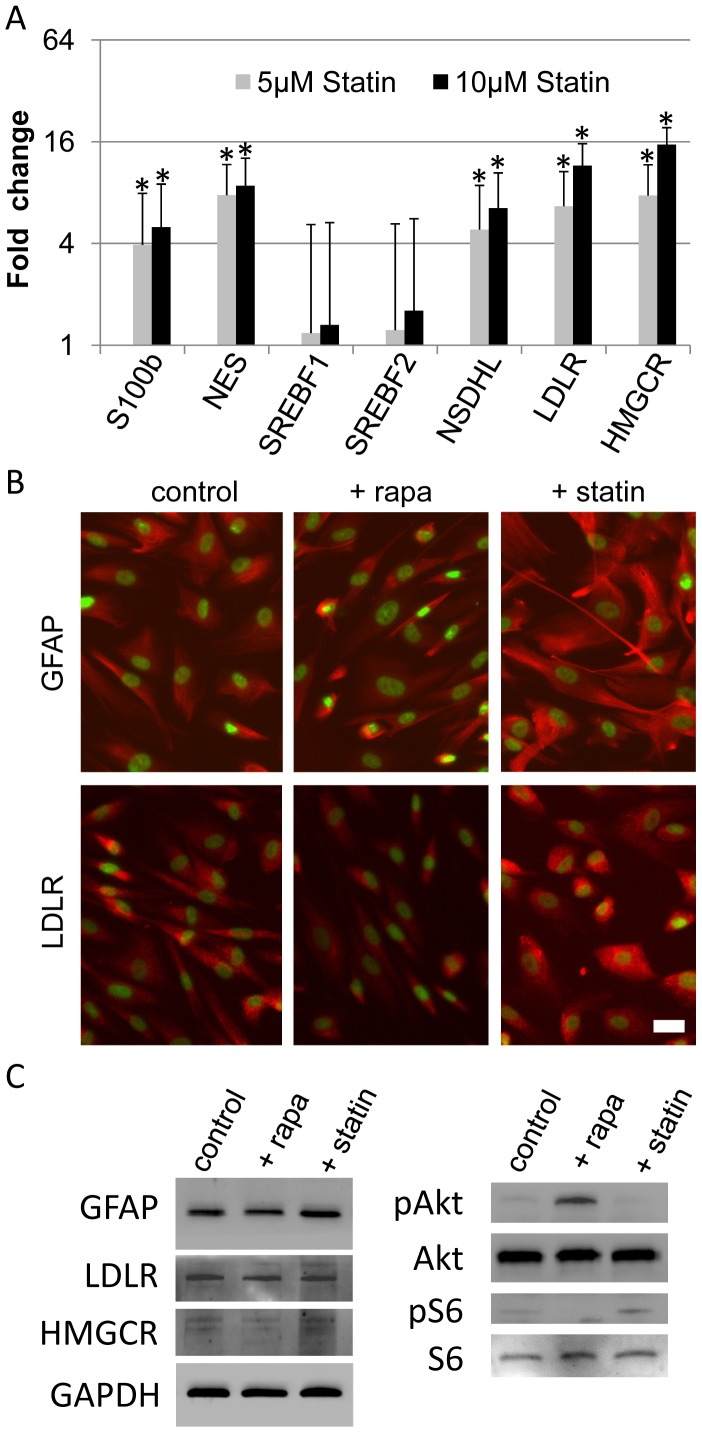
Rapamycin decreases Schwann cell markers, whereas statin induces Schwann cell markers.(A) During the last 72 hrs of differentiation, AFS cells were treated with 5 µM and 10 µM statin. After 15 days cDNA was generated and used for quantitative PCR of respective genes. The results are expressed as means ± SEM of three independent experiments. P<0,05 for * vs control treated cells. (B) AFS cells were differentiated for 15 days and since day 5 continuously treated either with 25 nM rapamycin or 1 µM of statin. Fixed cells were stained with indicated antibodies (labeled in red, nuclei in green). Scale bar represents 10 µm. (C) Western blotting of cells differentiated for 15 days and since day 5 continuously treated either with 25 nM rapamycin or 1 µM of statin. GFAP was detected at about 50 kDa, LDLR at 160 kDa and HMGCR as a double band at 90 kDa.